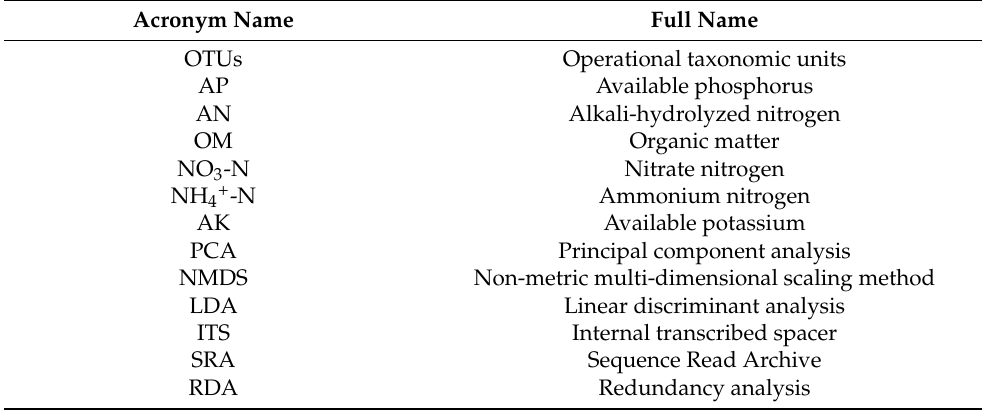
Table 1. List of